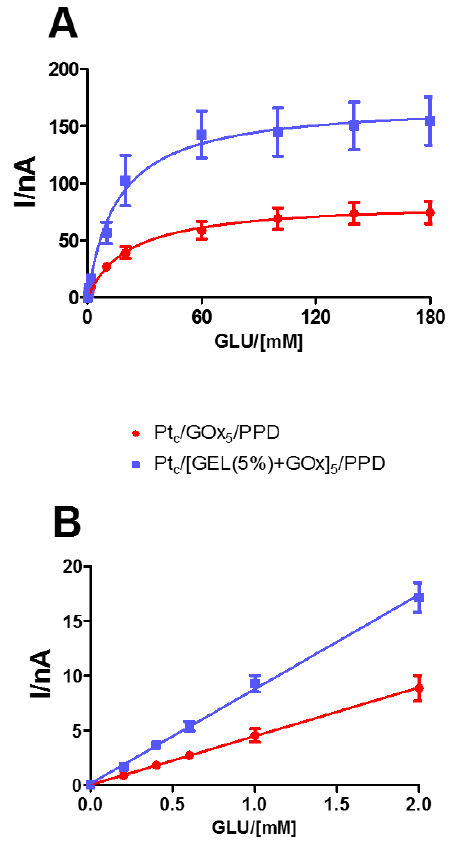
Figure 3. ( A ) Michaelis − Menten kinetics with a range of 0–180 mM and relative 0–2.0 mM linear regression; ( B ) plots of different glucose biosensor designs (n = 4) loading GOx alone (red line: Pt c /GOx 5 /PPD) or mixed with starch-based hydrogel (5%) (blue line: Pt c /[GEL (5%) + GOx] 5 /PPD). Values are expressed as mean ± SEM. * p < 0.05 vs. red line.